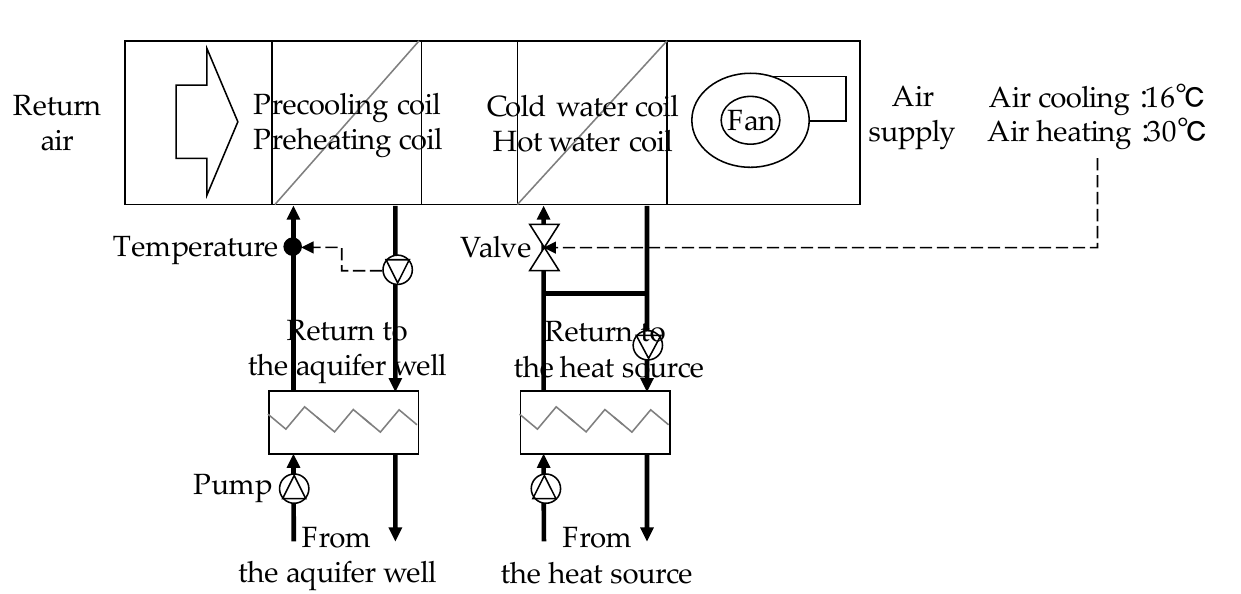
Figure 10. System diagram of air conditioning system for ATES system.